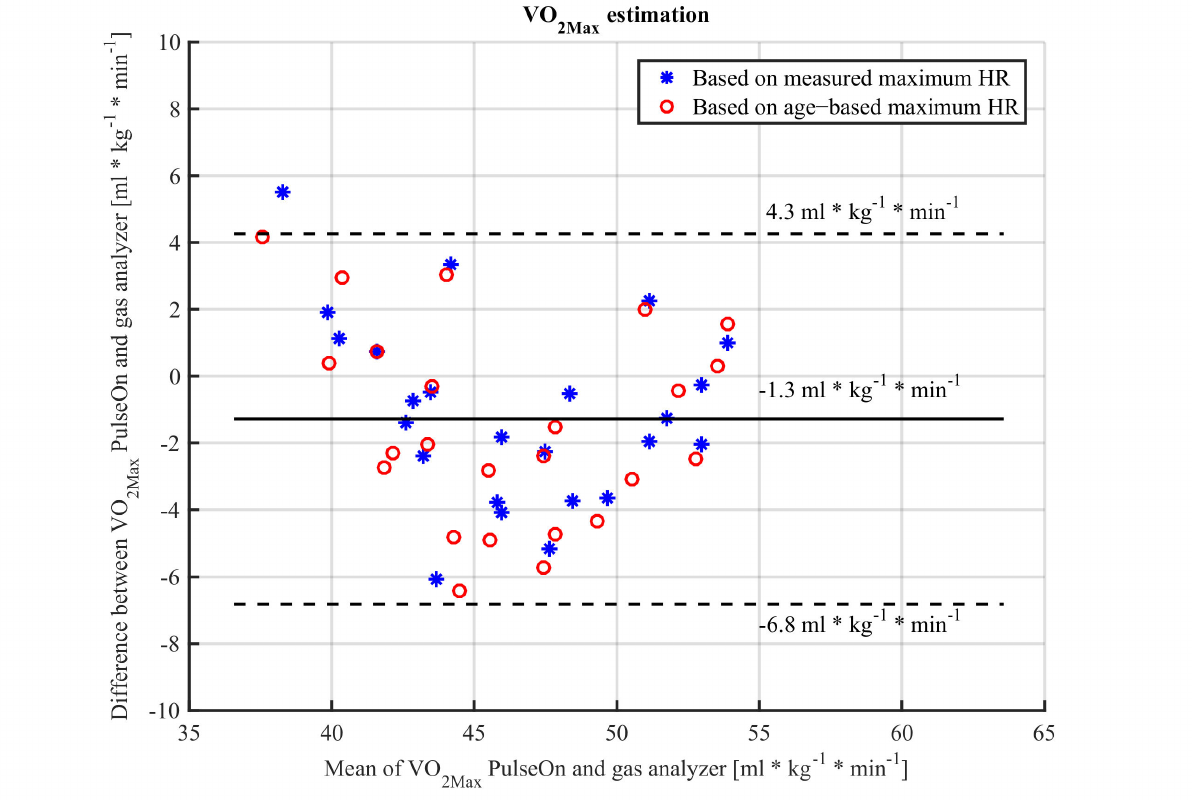
Figure 4. Bland−Altman plot of VO2Max estimates from the PulseOn app (wrist PPG device + phone GPS) during a submaximal exercise test versus gas analyzer based estimate during maximal exercise tests−dots represent data when age−based maximum HR is used for an estimation, while an asterix represents estimations based on true measured maximum HR (solid horizontal line: bias, dashed lines: 95% confidence limits of agreement).